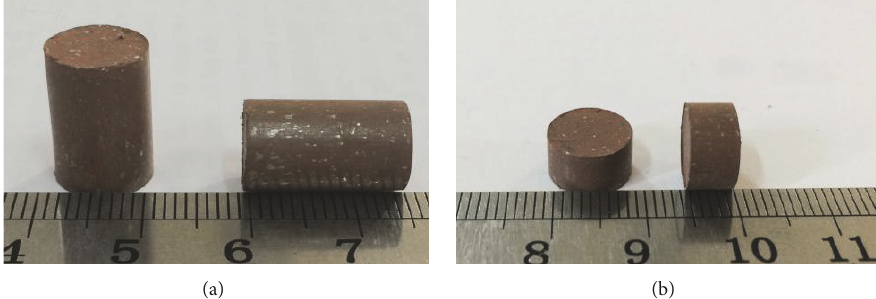
Figure 1: Samples of PTFE/Al/Fe 2 O 3 composites: (a) for quasi-static compression and (b) for drop-weight